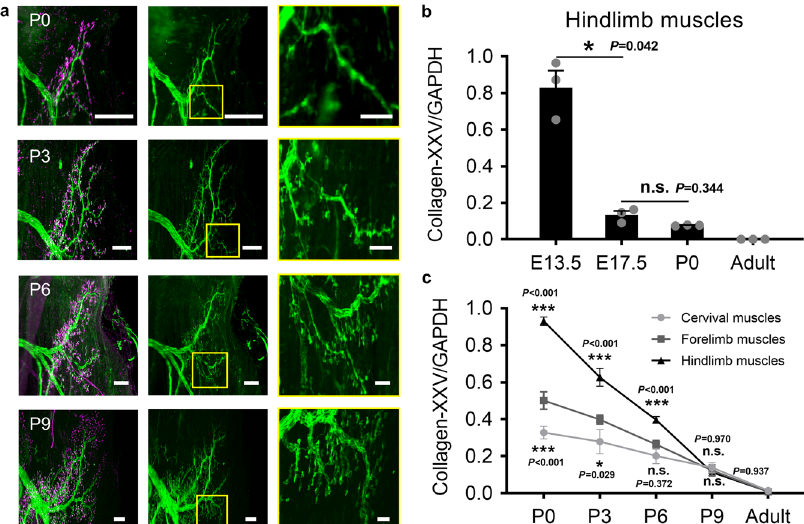
Fig. 4 Intramuscular axonal arborization during postnatal development. a A comparison of the motor nerve arborizations in the gastrocnemius during postnatal development. The images in the yellow frames in the second column are enlarged and presented in the third column: they show increased axonal terminals and branches on the selected branch during postnatal development. Scale bar in white frames: 100 μ m; scale bar in yellow frames: 30 μ m. b qRT- PCR analysis of collagen XXV mRNA expression in embryonic (E13.5 and E17.5), neonatal (P0), and adult hindlimb muscles ( n = 3 independent animals for each time point). mRNA levels were normalized to GADPH expression. c qRT-PCR analysis of collagen XXV mRNA expression in postnatal and adult muscles from the cervical part, forelimb, and hindlimb ( n = 6 independent animals for each body part at each time point). All values are presented as the means ± SEM; statistical signi fi cance in b and c (n.s. represents not signi fi cant, *P < 0.05, and ***P < 0.001) was assessed using one-way ANOVA and two- way ANOVA, and followed by Dunnett ’ s T3 post hoc test and Tukey post hoc test